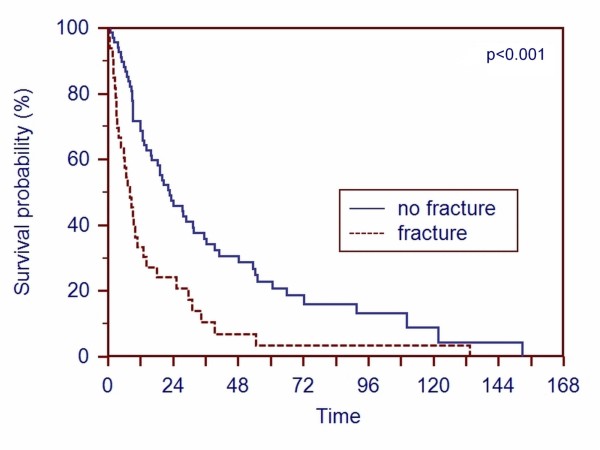
A Kaplan-Meier survival curve of patients based on whether a pathologic fracture was present before the operation or not shows that presence of a pathologic fracture decreases the prognosis of the patient (p < 0.001).